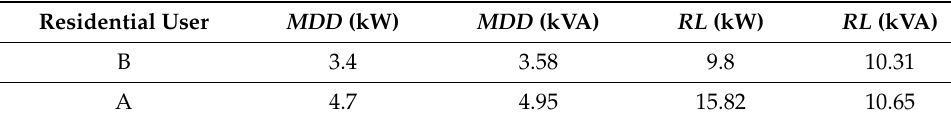
Table 3. Simulation model